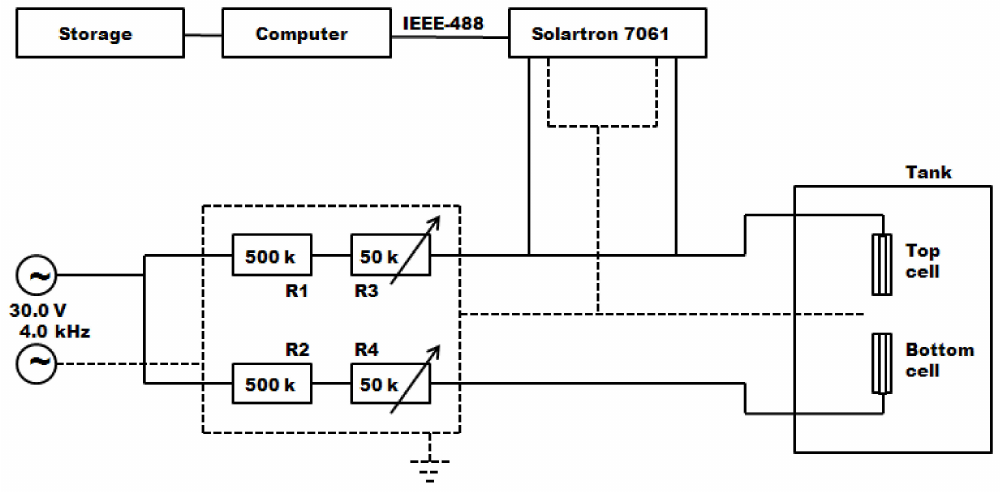
Figure 1. Scheme of the open-ended conductimetric technique [1]. R1, R2, R3 and R4 are